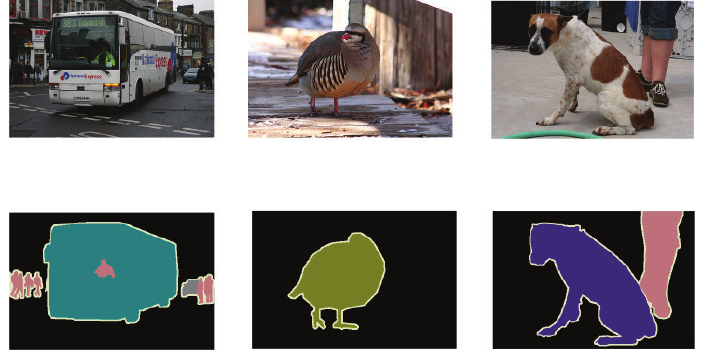
Figure 3: A semantic image segmentation algorithm uses the upper images as input and returns the lower images as